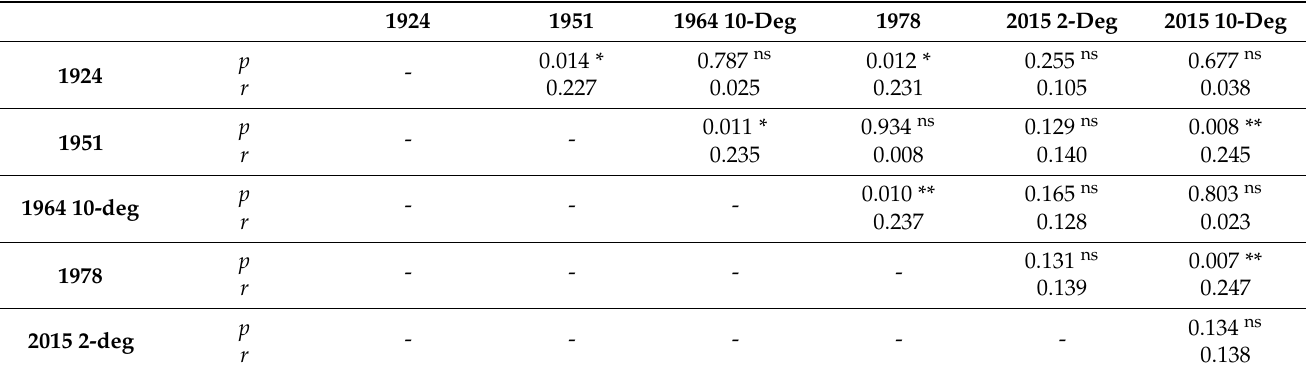
Table 6. Rank sum test and effect size for CIE 1976 v (cid:48) ( p -value and effect size ( r